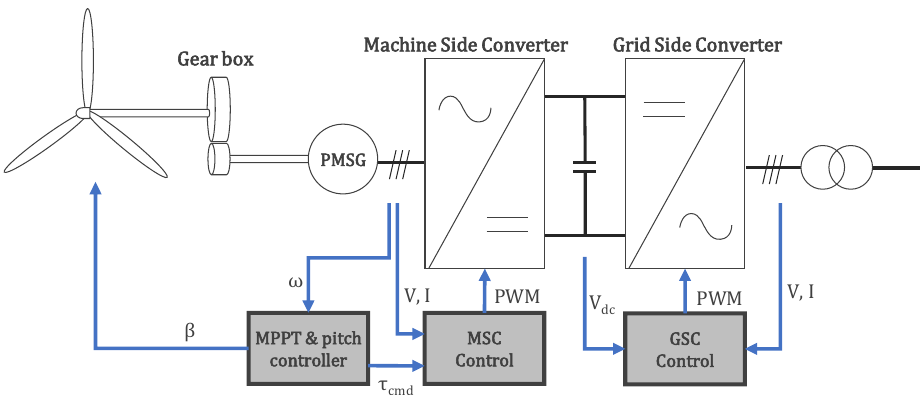
Figure 1. Configuration of the PMSG-type wind turbine.